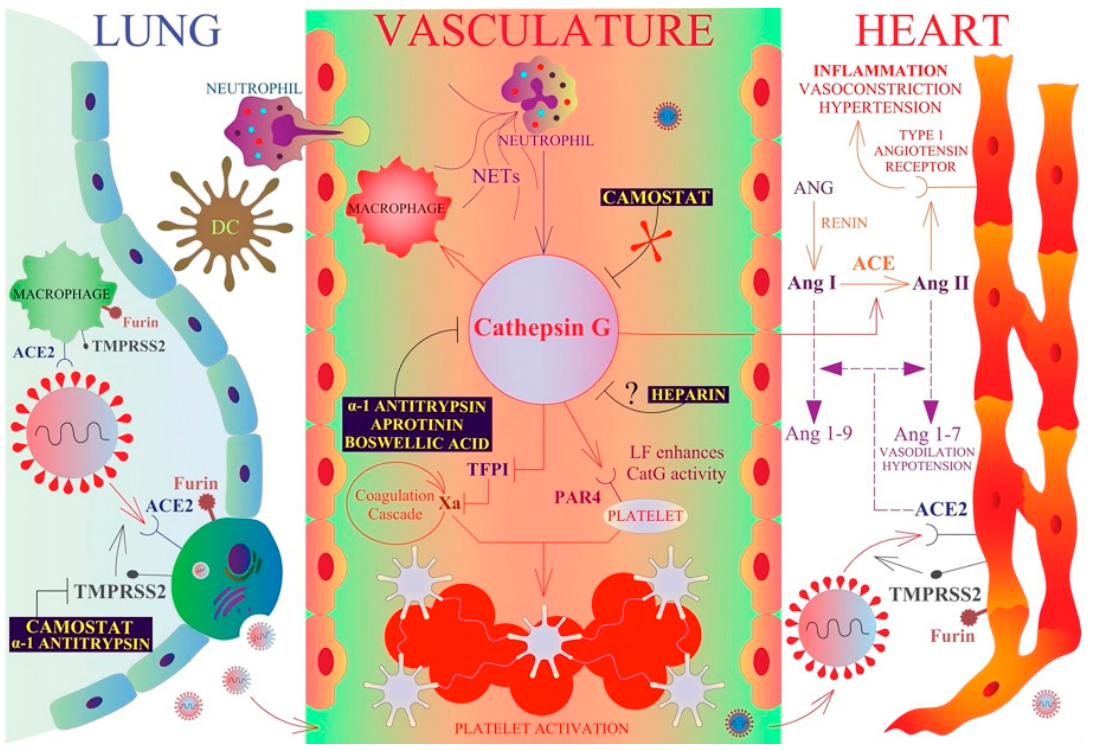
Figure 6. A model of CatG in SARS-CoV-2 infection and inflammation. Activated neutrophils segregate CatG into extracellular space where CatG hydrolyzes the protease-activated receptor 4 (PAR4) on